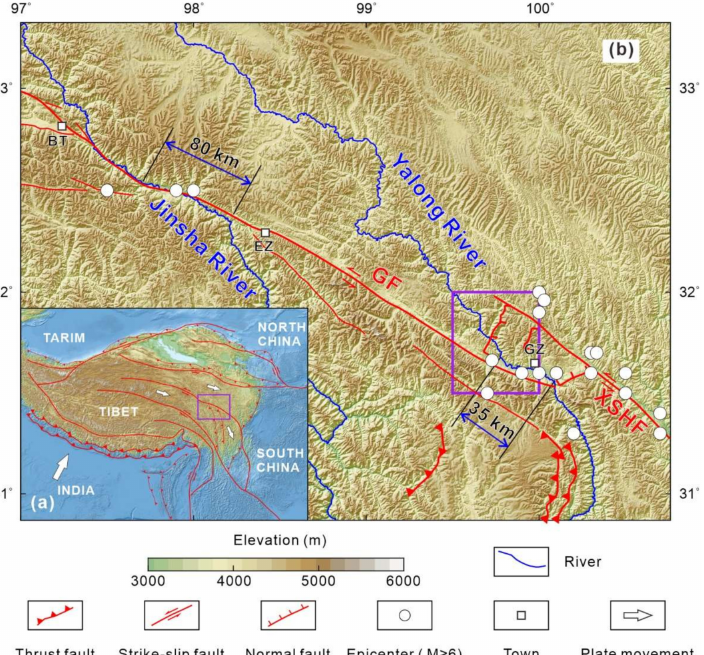
Figure 1. ( a ) Tectonic map of the Tibetan Plateau with topographic relief. ( b ) Digital elevation map of the Ganzi fault region with active faults in red, main rivers in blue, and historical earthquakes in white circles. GZ, Ganzi; EZ, Ezhi; BT, Batang; XSHF, Xianshuihe fault; GF, Ganzi